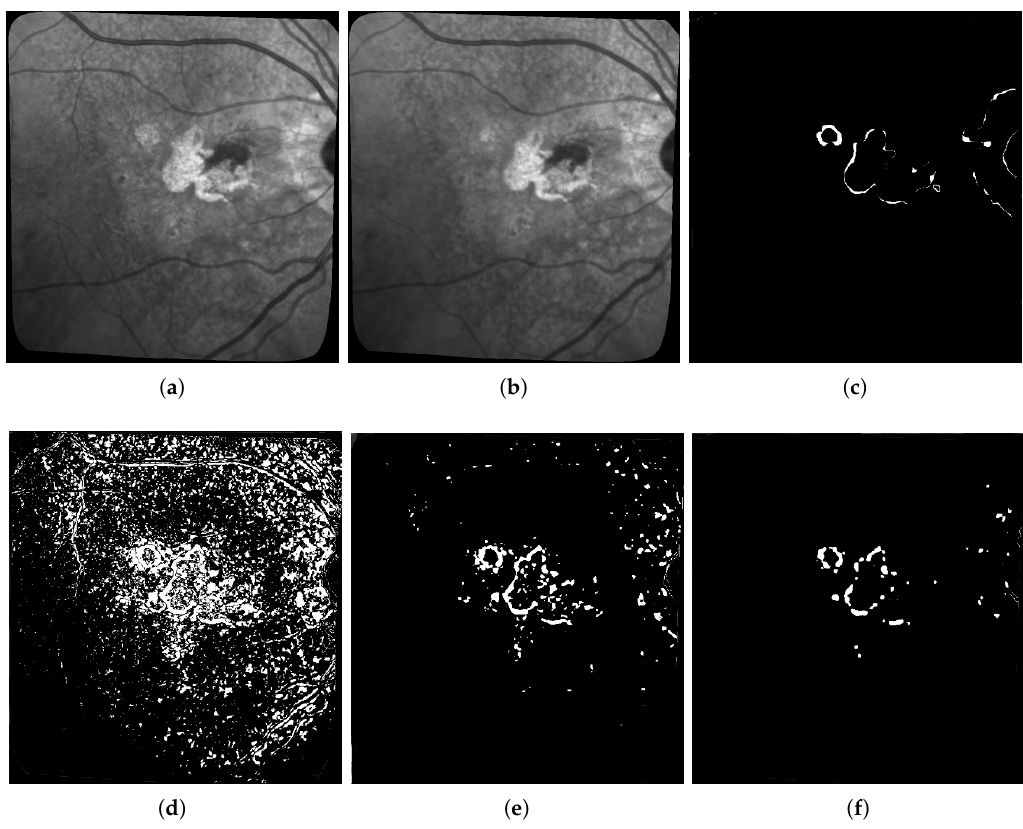
Figure 11. Comparison example of the three methods on patient 010. ( a ) Corrected Image from November 2017; ( b ) Corrected Image from May 2018; ( c ) Proposed ground truth; ( d ) Otsu thresholding, F1 score = 0.05; ( e ) Turgay Celik’s approach, F1 score = 0.253; ( f ) Our Fully convolutional AE, F1 score =